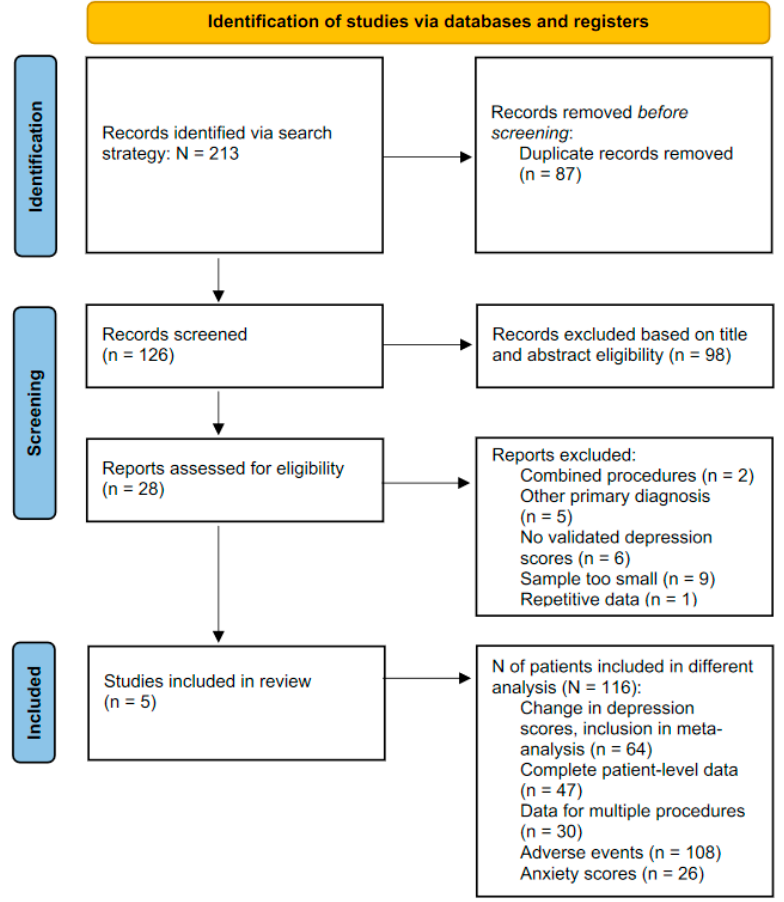
Figure 2. PRISMA flow diagram summarising the study selection process.